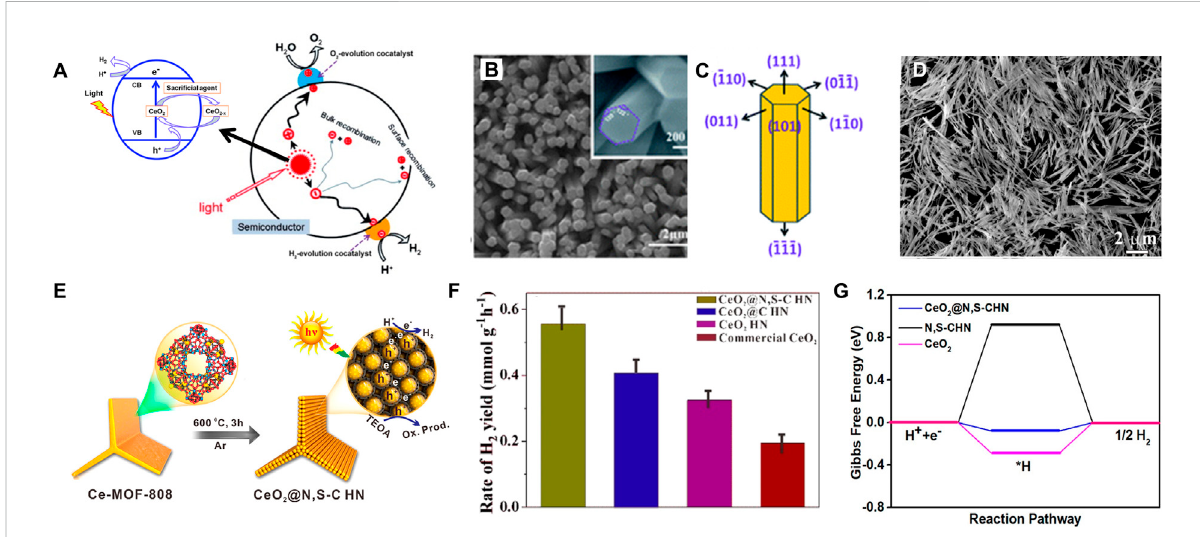
FIGURE 8 Applications of CeO 2 -based nanostructures for photocatalytic hydrogen evolution reaction: (A) Processes involved in CeO 2 -based photocatalytic water splitting reaction. Reproduced with permission (Lu et al., 2011; Xu and Xu, 2015) Copyright 2015, Elsevier. (B,C) The oriented hexagonal CeO 2 nanorods with (110) as the predominantly exposed planes. Reproduced with permission (Lu et al., 2011). Copyright 2011, Royal Society of Chemistry. (D – G) Combining N,S-codoped C and CeO 2 in a 3D hinge-like structure for ef fi cient photocatalytic hydrogen evolution. Reproduced with permission (Hao et al., 2020). Copyright 2020, American Chemical